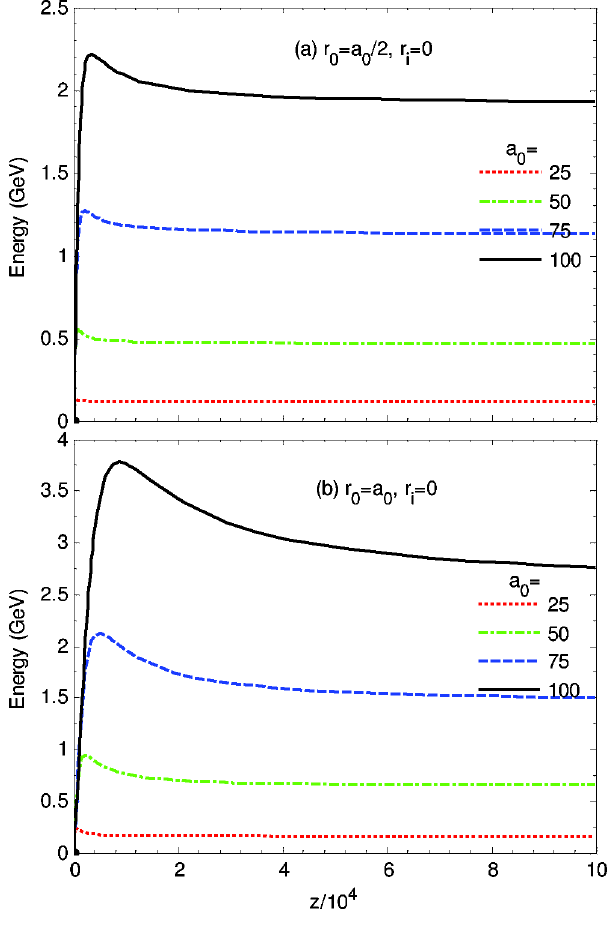
.FIG. 5. Electron energy K (GeV) as a function of normalized z for (a) r 0 ¼ a 0 = 2 and (b) r 0 ¼ a 0 for r i ¼ 0 . Dotted,